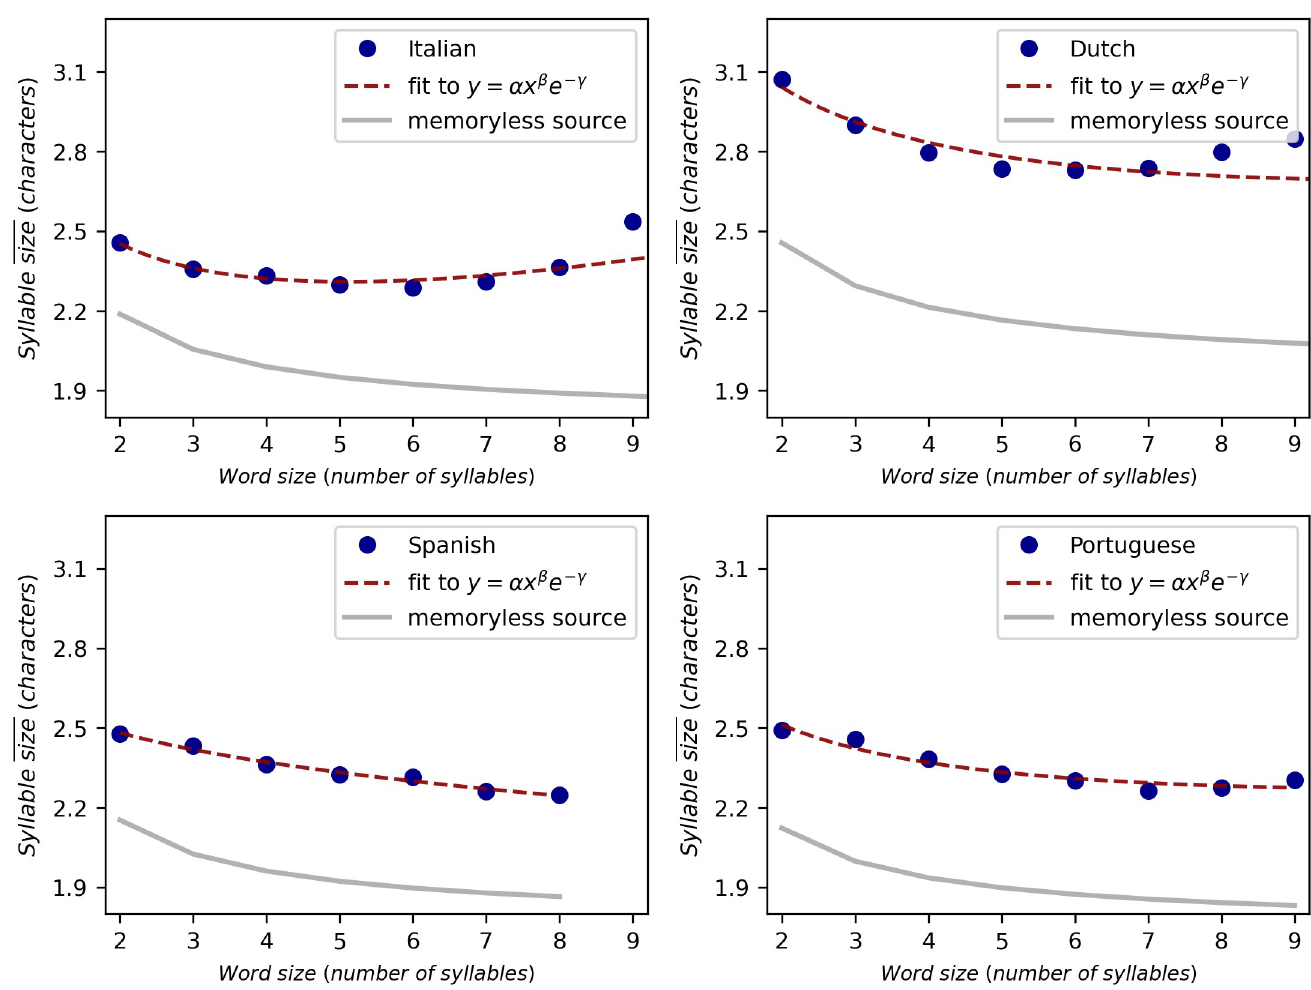
Fig 4. Menzerath-Altmann’s law and the memoryless source baseline. Relation between the word size and the mean size of syllables for Italian, Dutch, Spanish and Portuguese. Experimental results are shown in blue circles, the red dotted line is a fit to Menzerath-Altmann’s law (2), whereas the gray solid line corresponds to Eq (4) with p c given by the relative frequency of consonants. Results for 17 additional languages are provided in S2